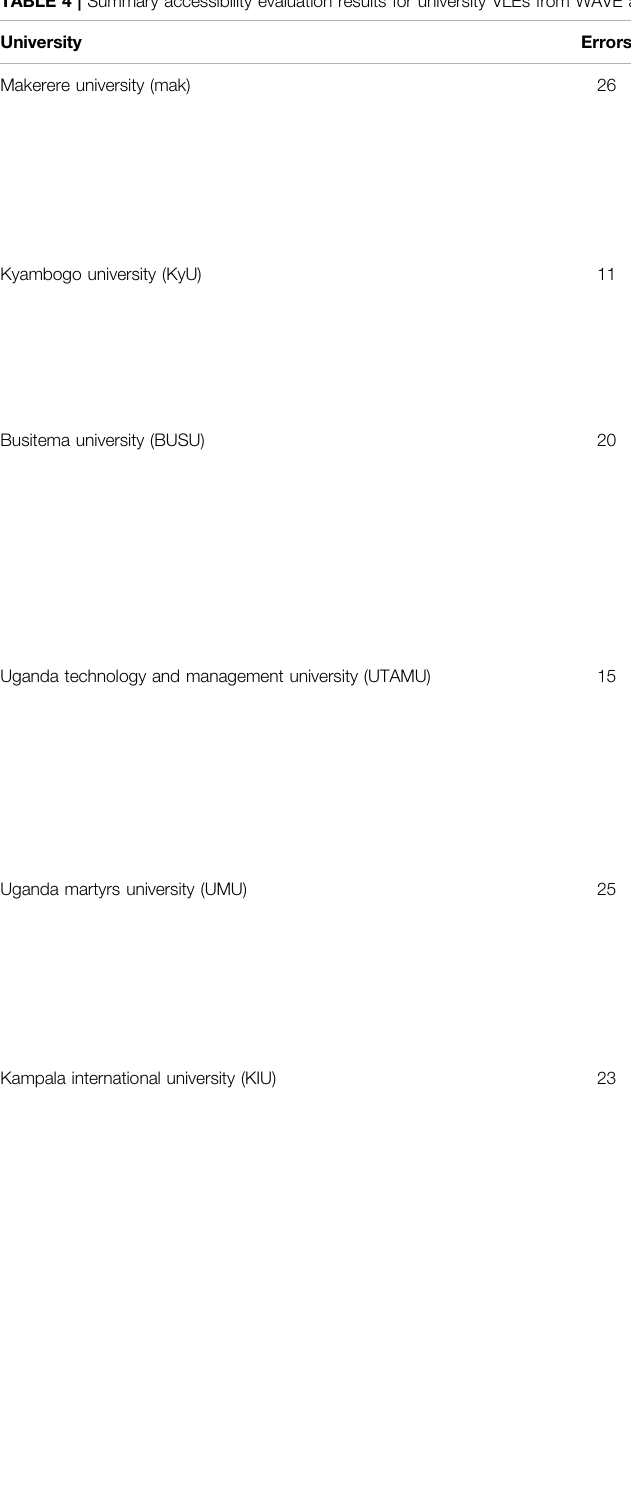
TABLE 4 | Summary accessibility evaluation results for university VLEs from WAVE accessibility evaluation